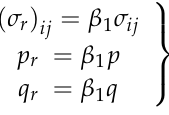
Figure 10. Sensitivity of perturbation for the Kaolin clay.